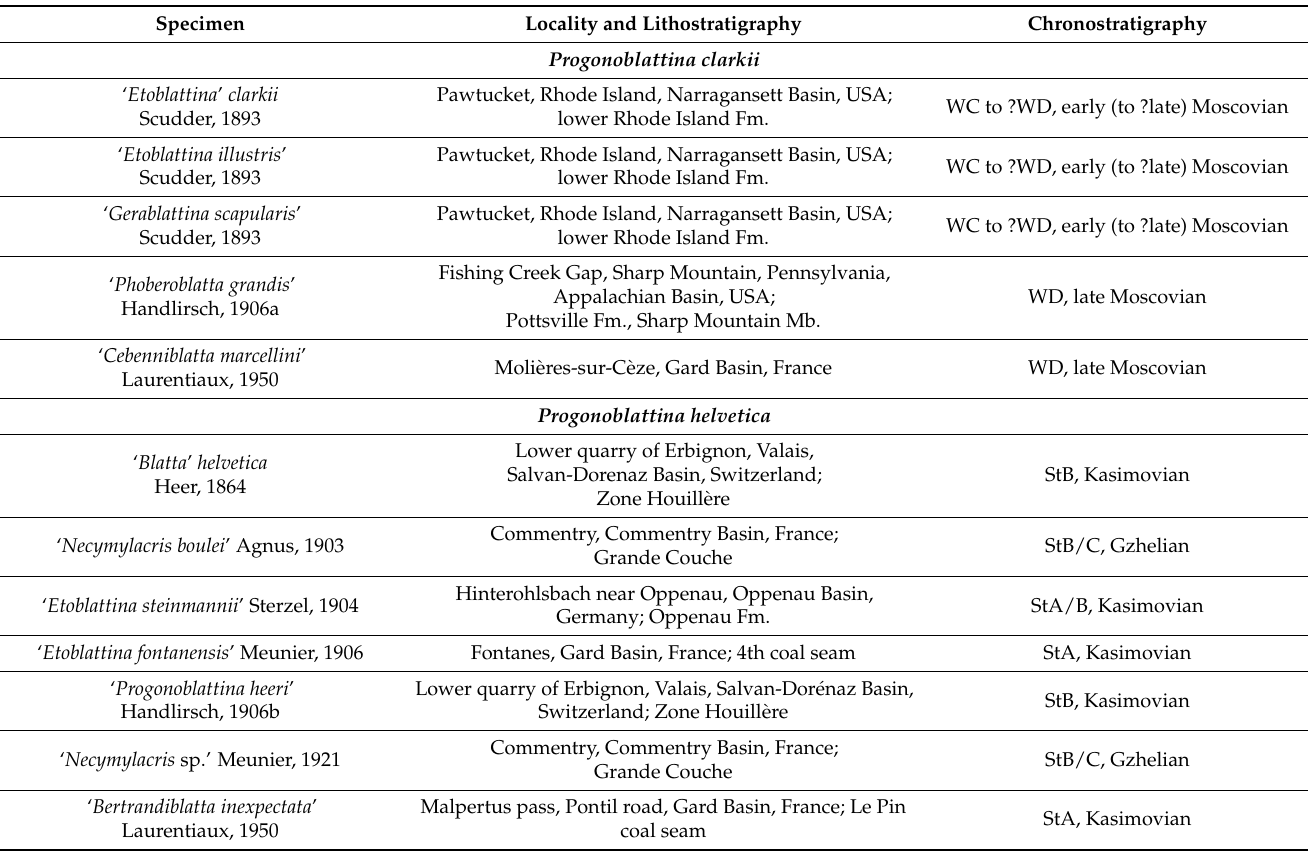
Table 1. Overview of the discussed taxa with their occurrences. Abbreviations: WB, WC, WD— Westphalian B, C, D etc.; StA, StB, StC—Stephanian A, B, C etc.; Fm.—Formation. Specimen Locality and Lithostratigraphy